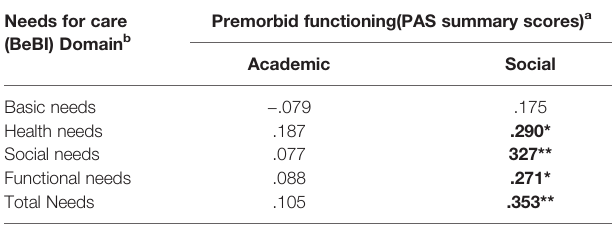
TABLE 5 | Association of premorbid functioning with needs for care (Spearman rank